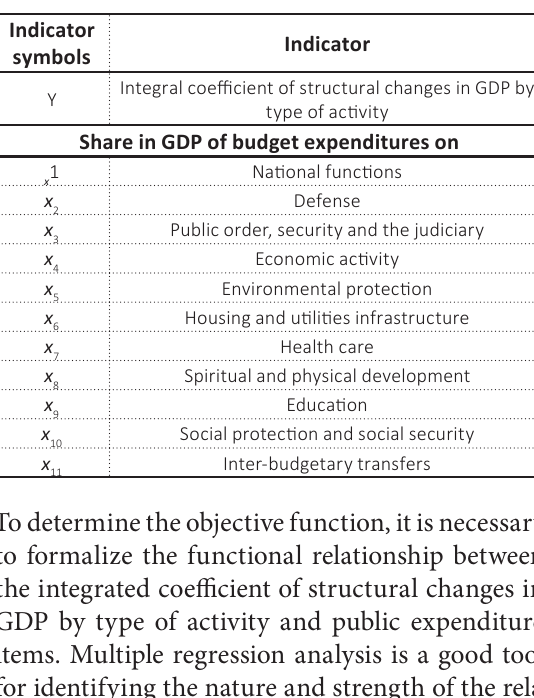
Table 1. Symbols of indicators used to build economic and mathematical optimization